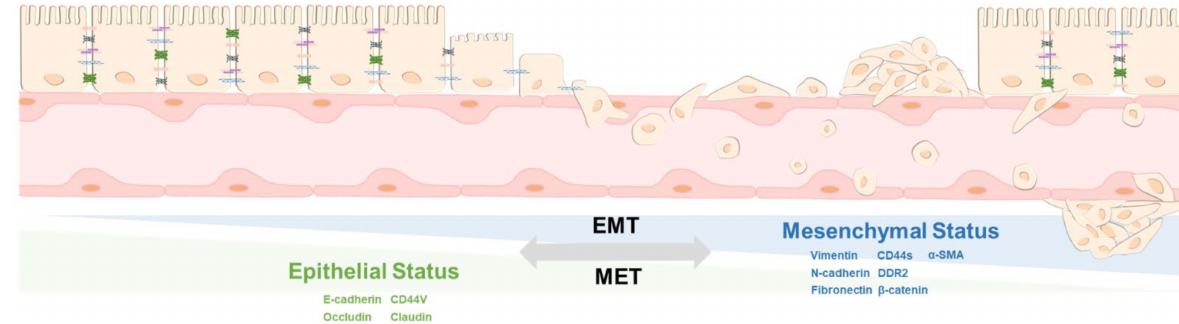
Figure 1. The regulation of EMT and MET. Epithelial cells can transform the original cell type from epithelial status to mesenchymal status through the EMT process, and its ability to move, such as entering the circulation system and then returning to epithelial status, through the conversion of MET. Therefore, the level of EMT and MET mobility and its corresponding markers to distinguish the types of EMT and MET is described.